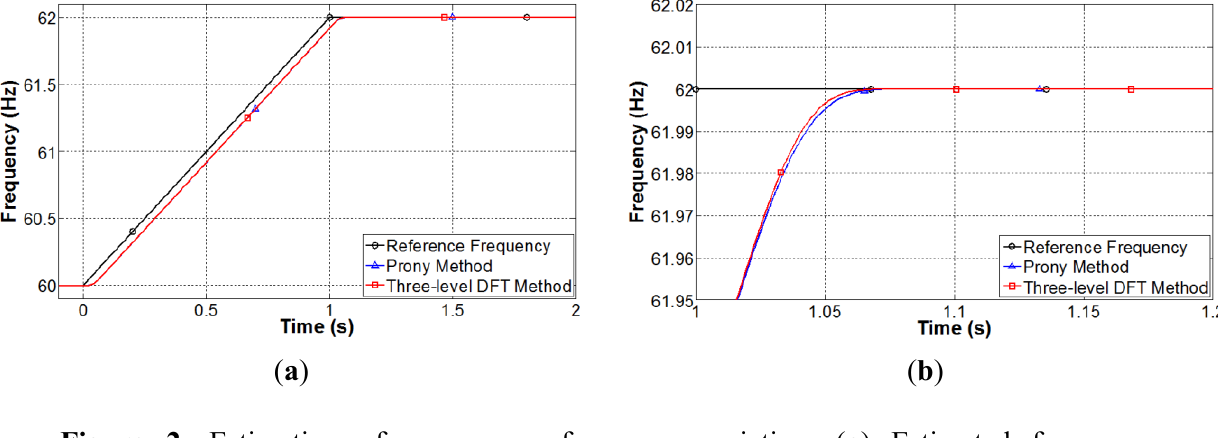
Figure 2. Estimation of a ramp-up frequency variation. ( a ) Estimated frequency; ( b ) Close-up of the convergence.